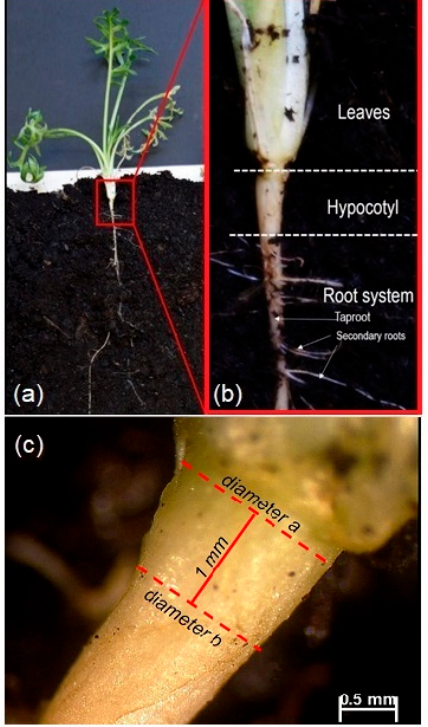
Figure 1. ( a ) Habitus of young maca seedling at 60 DAS; ( b ) morphological structure of maca seedlings indicating leaves, hypocotyl and root system consisting of a taproot and secondary roots; ( c ). hypocotyl of maca plant (2.5× magnification) grown in rhizoboxes under controlled conditions. Dashed lines indicate diameter a and diameter b where measurements have been performed.